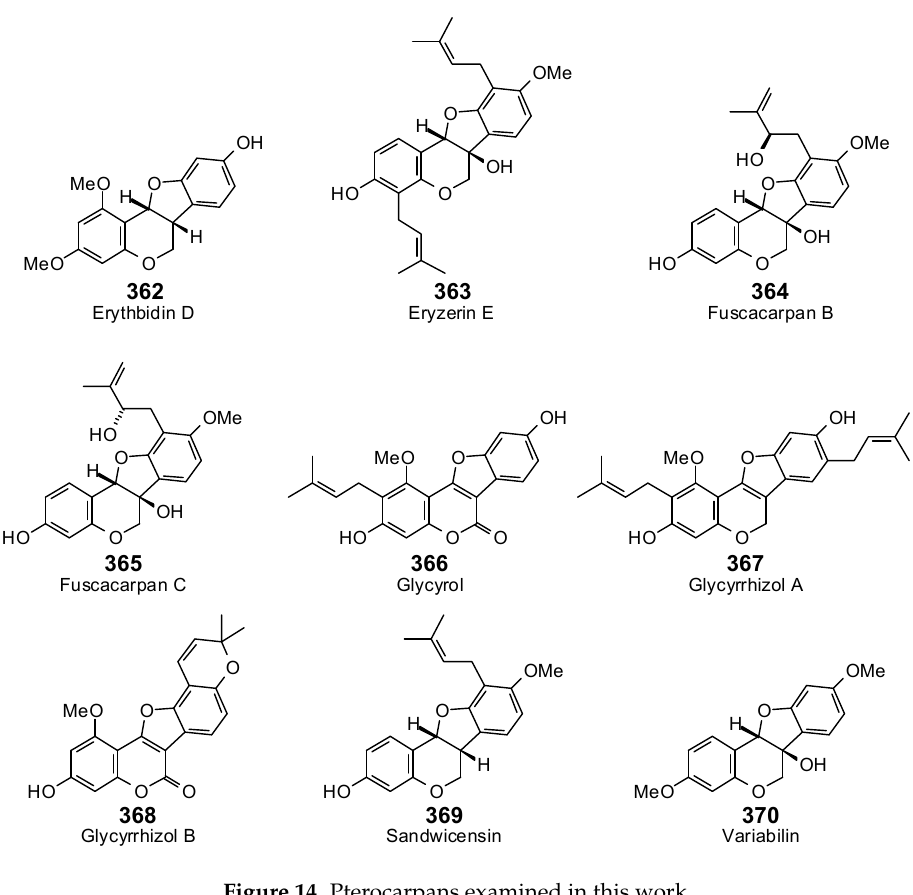
Figure 14. Pterocarpans examined in this work.